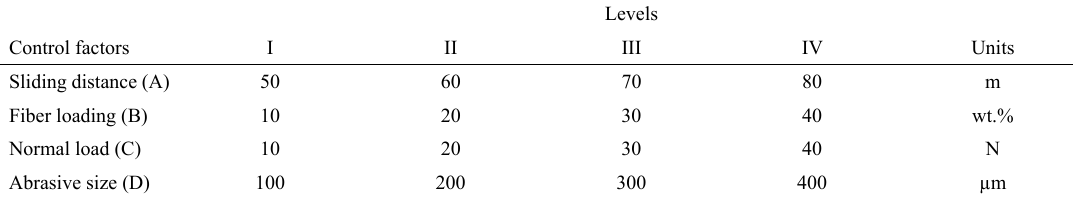
Table 2. Levels of the variables used in the experiment.